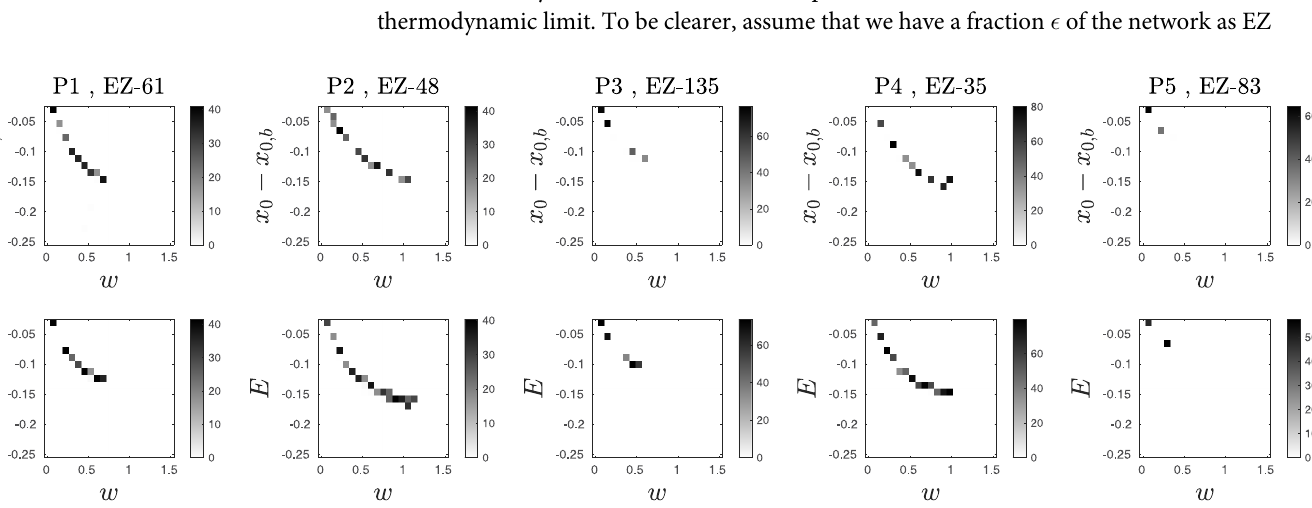
PLOS Computational Biology | https://doi.org/10.1371/journal.pcbi.1010852 February7,